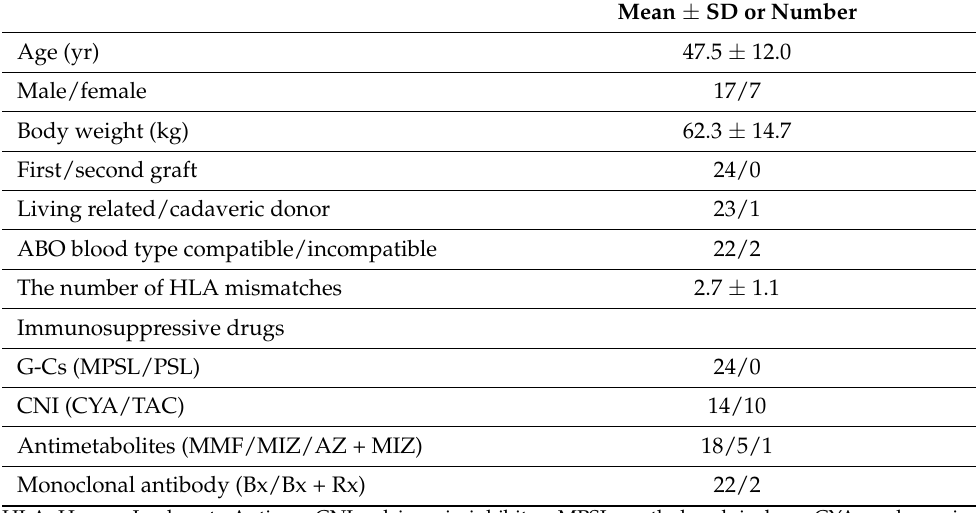
Table 1. The recipient